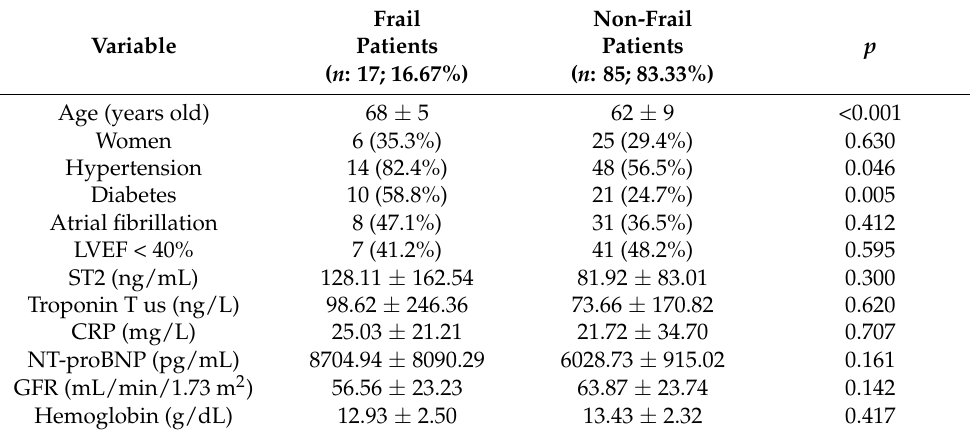
Table 1. Baseline characteristics in the group of young patients.